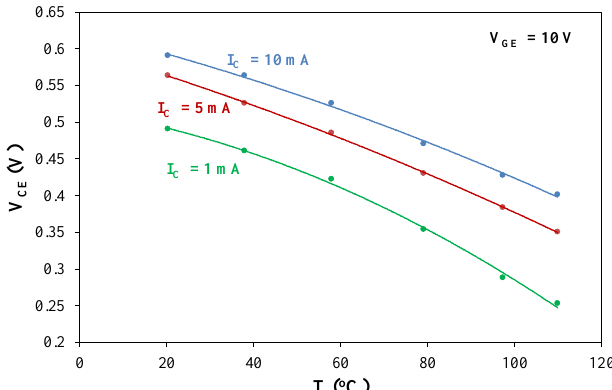
Figure 7. Thermometric characteristics V GE (T) for selected values of the collector current. As can be noticed, characteristics V GE (T) show considerably higher (almost four times) sensitivity of the thermo-sensitive parameter at changes in temperature than characteristics V D (T) . This means that, at the same accuracy of measurements of both voltages, four times higher resolution of measurements of the device internal temperature using V GE voltage as a thermo-sensitive parameter can be obtained. Figure 8 illustrates the dependences V CE (T) measured at selected values of I M current. The presented dependences were obtained at V GE voltage equal to 10 V, which is much higher than the threshold voltage.